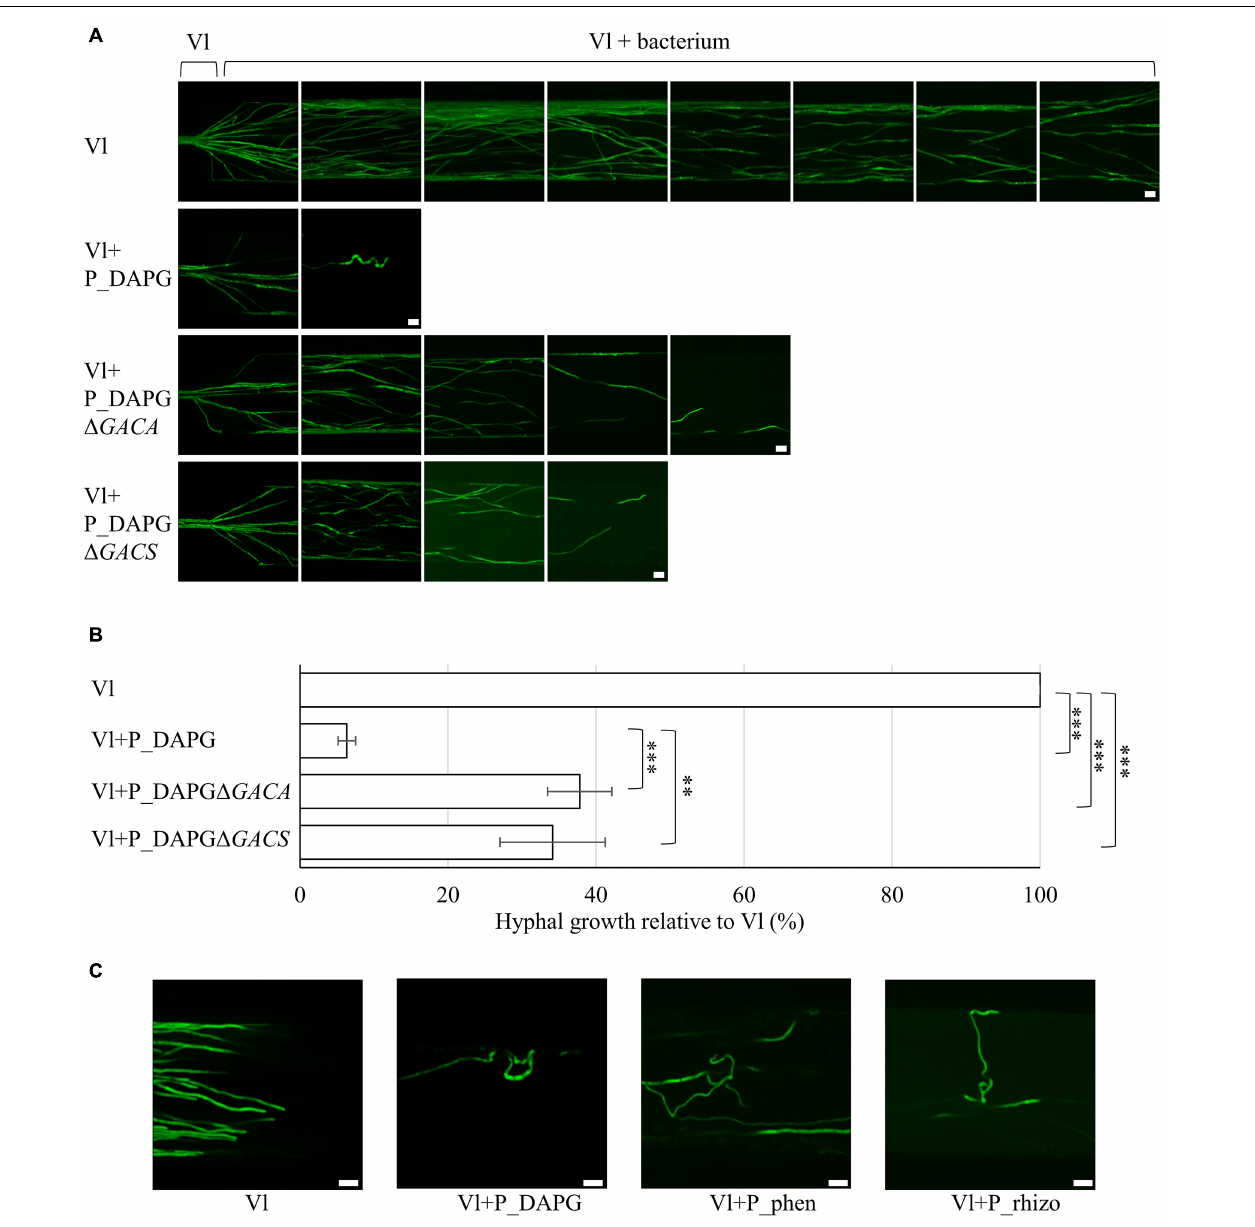
FIGURE 2 | Fluorescent pseudomonads inhibit fungal growth and induce polarity changes in microfluidic devices. Co-cultivation was performed in liquid pectin-rich simulated xylem medium. V. longisporum Vl43 producing high amounts of GFP (Vl) was inoculated at one side of the device with an agar block containing hyphae. The device was incubated at 25 ◦ C until hyphae entered the microchannels. As soon as the fungal hyphae reached the beginning of the interaction channels fluorescent pseudomonads were inoculated at the opposite end of the channel. Bacteria spread throughout the device. (A) Representative micrographs of a V. longisporum strain producing high amounts of GFP without (Vl) and with fluorescent bacteria with genes for DAPG synthesis (Vl + P_DAPG) and respective mutant strains, which lack the GacS/GacA two-component control system for the synthesis of various metabolites (Vl + P_DAPG (cid:49) GACS , Vl + P_DAPG (cid:49) GACA ). Images were acquired from three devices with 28 interaction channels each. Fungal growth inhibition partially depends on the presence of GacS/GacA. Scale bars: 20 µ m. (B) Quantification of fungal growth in devices relative to V. longisporum growth without bacteria (Vl), which was set to 100% for each device. Bars represent the mean of three devices and error bars the respective standard deviation. Statistical significance was calculated with two-tailed Student’s T-test ( ∗∗ p < 0.01, ∗∗∗ p < 0.001). (C) Representative micrographs of a V. longisporum strain producing high amounts of GFP without (Vl) and with fluorescent bacteria with genes for DAPG (Vl + P_DAPG) or phenazines (Vl + P_phen) synthesis and a bacterium isolated from the rhizosphere of rapeseed (Vl + P_rhizo). Polar growth of V. longisporum is altered when cultivated together with different bacterial isolates resulting in a curly phenotype. Two (Vl + P_phen and Vl + P_rhizo) or three (Vl + P_DAPG) devices were evaluated. Scale bars: 20 µ